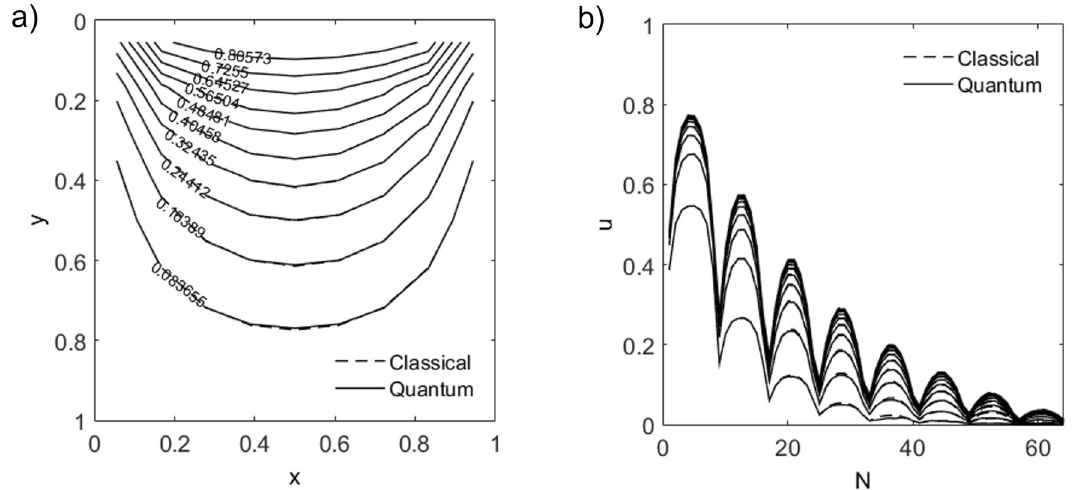
8 1 on a 8 × = 0, 0 ) and , g x R ) = ( x L